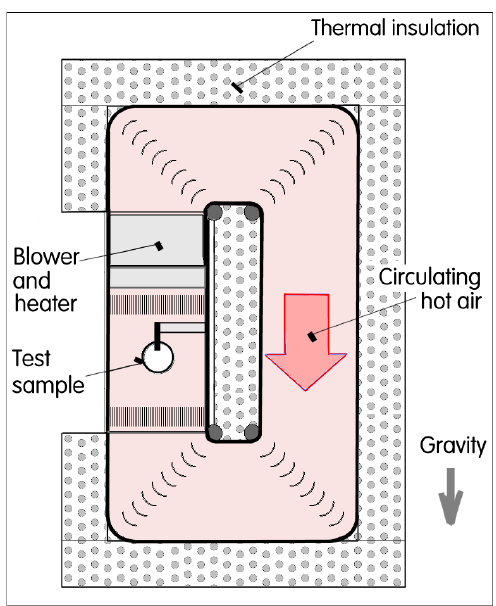
Fig. 17. Layout of the currently built wind tunnel for the latent heat tests. Hot air flow circulates in a vertically oriented loop. In the “up” arm at left is the test section and above it the combined unit for driving and heating the flow.